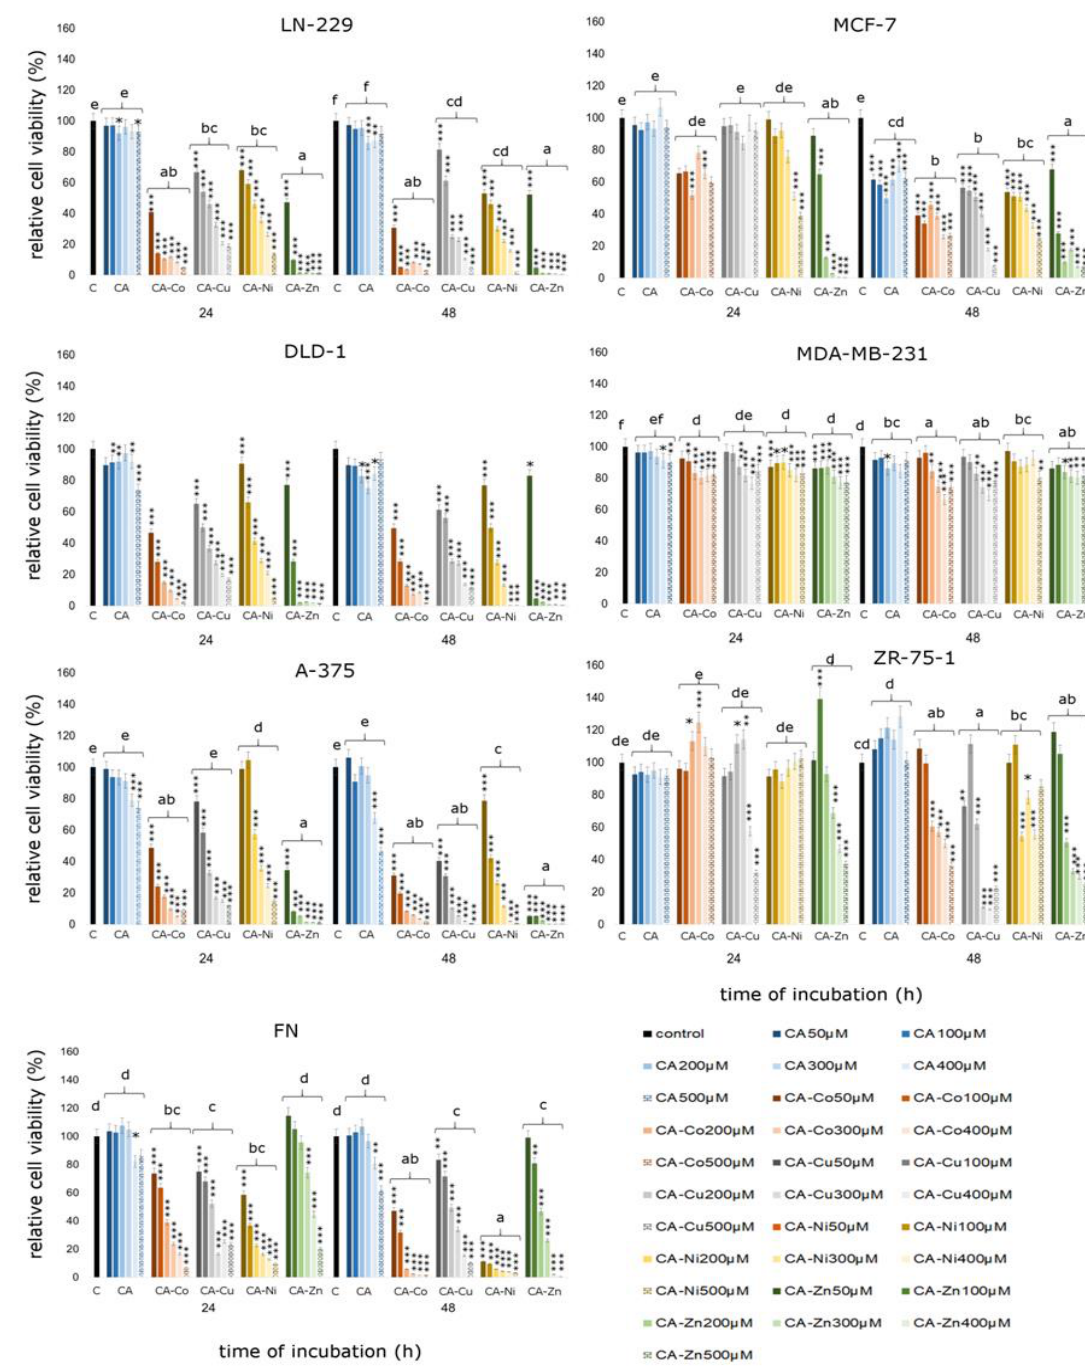
Figure 7. Cell viability results for MCF-7, MDA-MB-231, ZR-75-1, A375, DLD-1, LN-229, and FN cell lines exposed to different concentrations of CA and CA complexed with metals (Cu, Zn, Co, Ni) for 24 h and 48 h calculated as a percentage of control, untreated cells. Each value on the graph is the mean of three independent experiments and error bars show the standard deviation (SD). * p < 0.05, ** p < 0.01, and *** p < 0.001 represent significant effects between treatments and control followed by a Dunnett’s test.